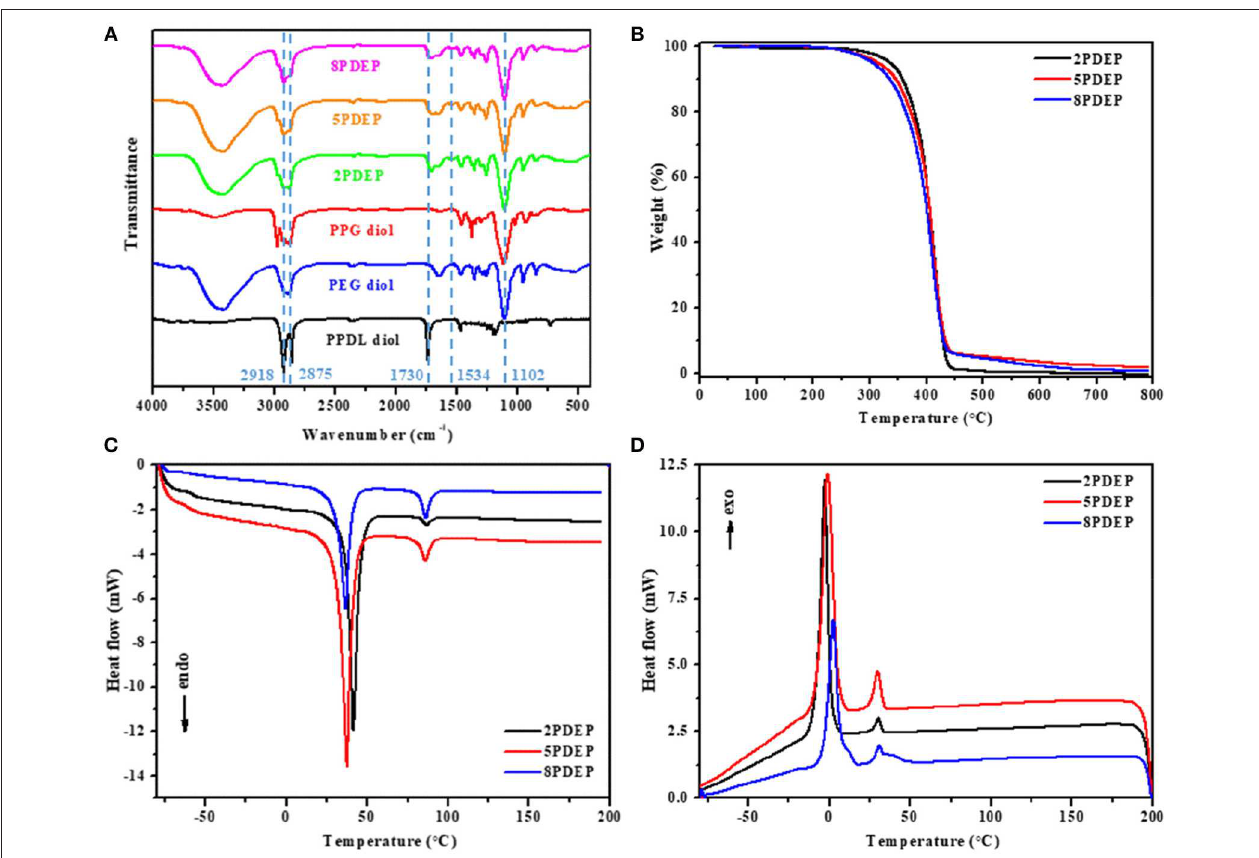
FIGURE 2 | (A) FT-IR spectra of PDEP copolymers and macrodiols, (B) TGA curves of PDEP copolymers, (C) DSC heating curves of PDEP copolymers and (D) DSC cooling curves of PDEP copolymers.